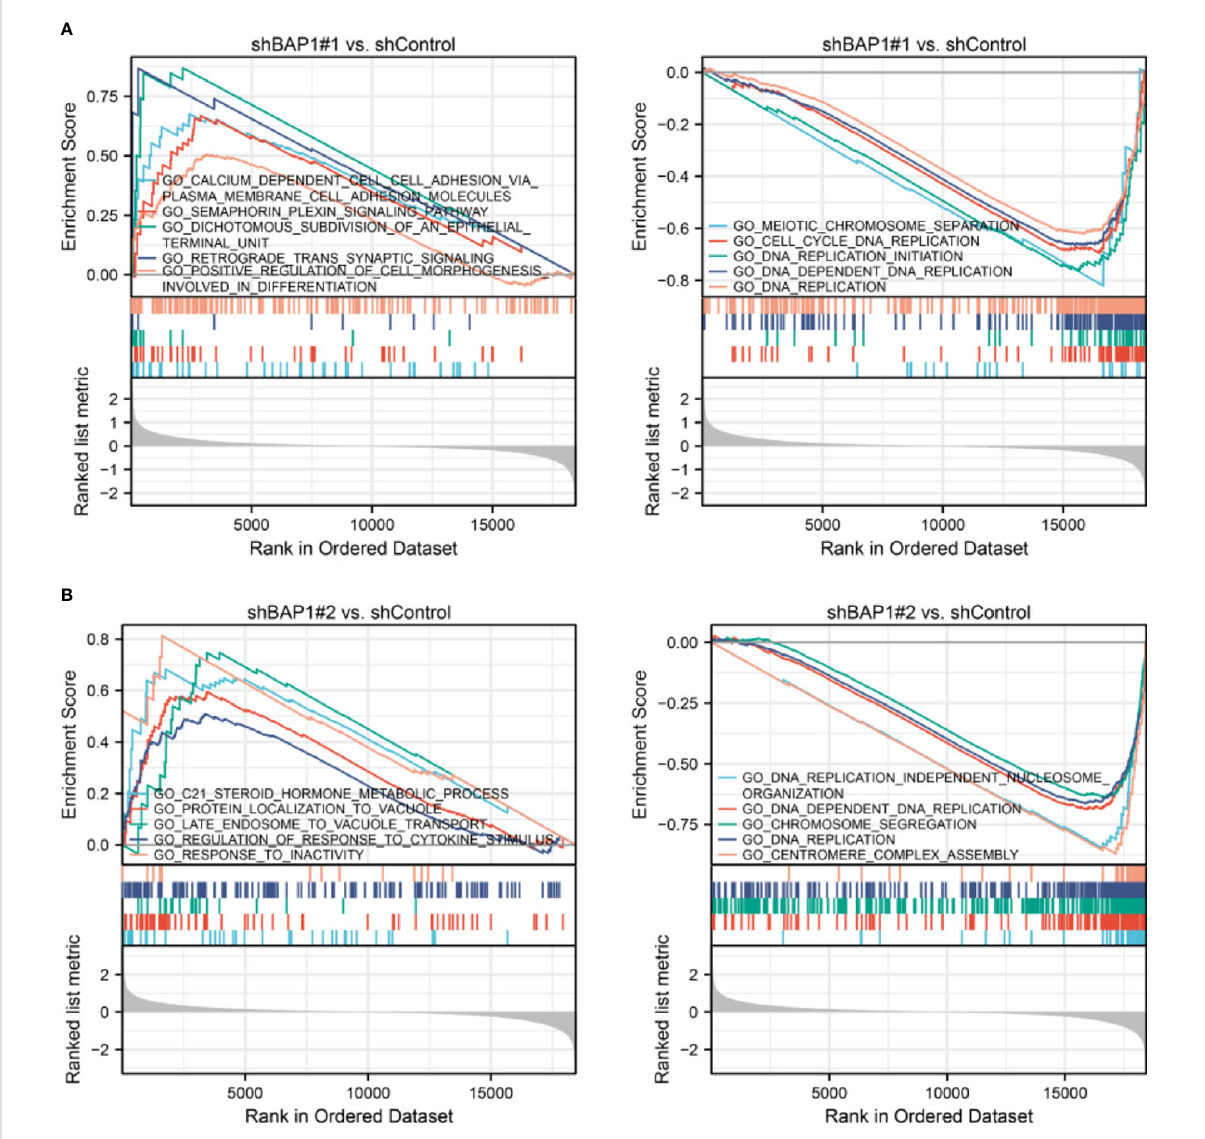
FIGURE 4 GSEA analysis in GO gene sets. (A) Top 5 GO terms with largest |NES| enriched in shBAP1#1 samples. (B) Top 5 GO terms with largest |NES| enriched in shBAP1#2